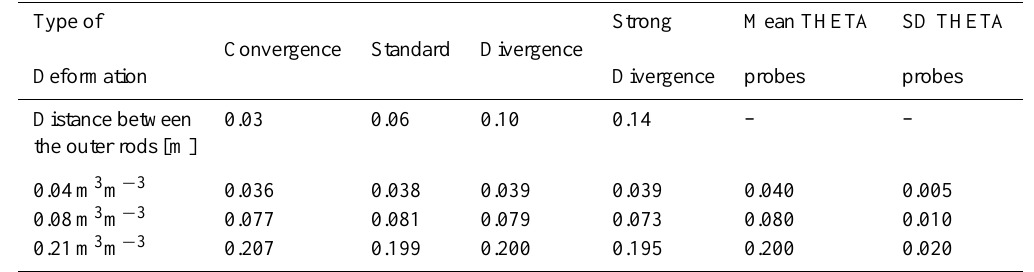
Table 5. Mean soil moisture observed with different probe deformations at soil moisture of approximately 0.04m 3 m − 3 , 0.08m 3 m − 3 and 0.20m 3 m − 3 estimated with SUSU03 and THETA probes. Standard deviation is abbreviated as SD.